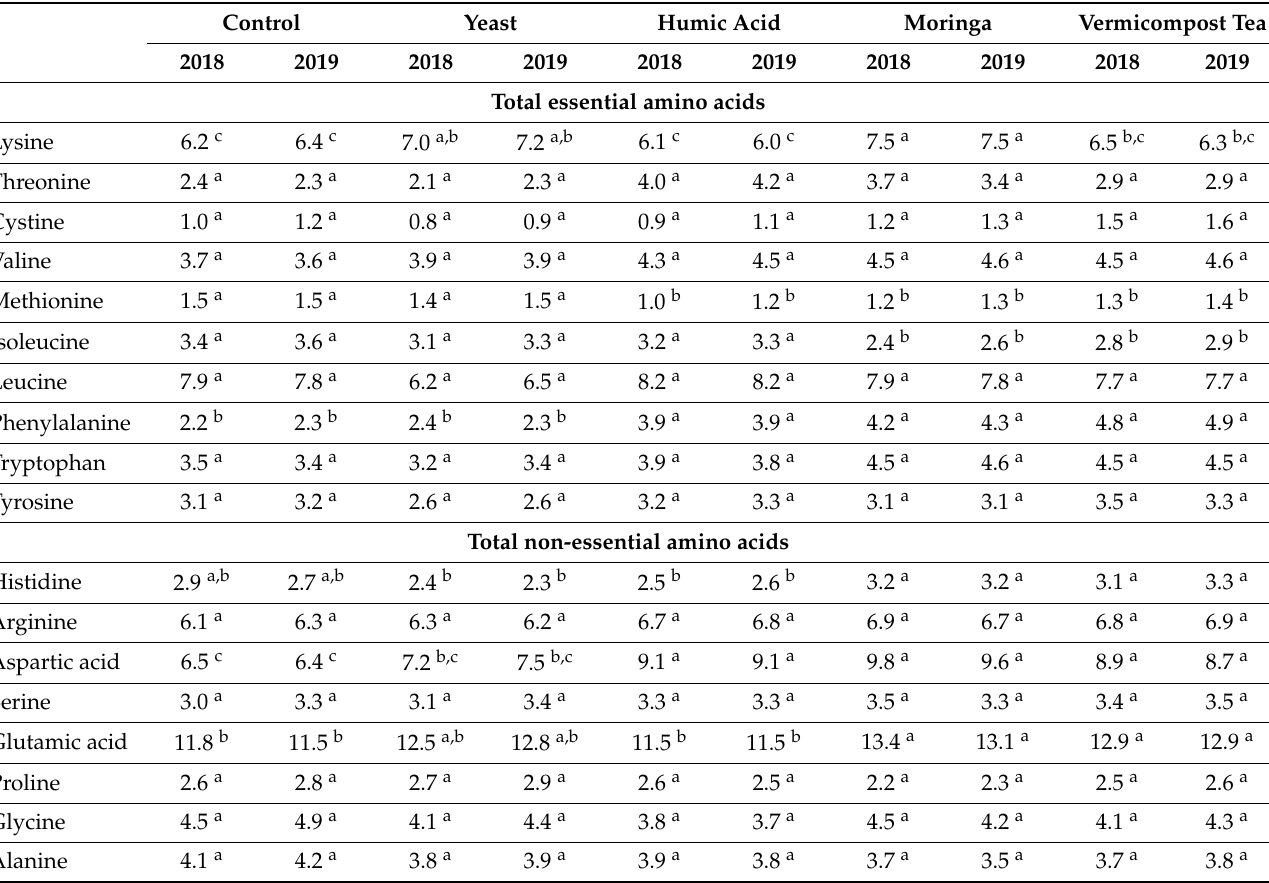
Table 13. Effect of biostimulants on amino acids content (g/100 g crude protein) of snap bean in growing seasons of 2018 and